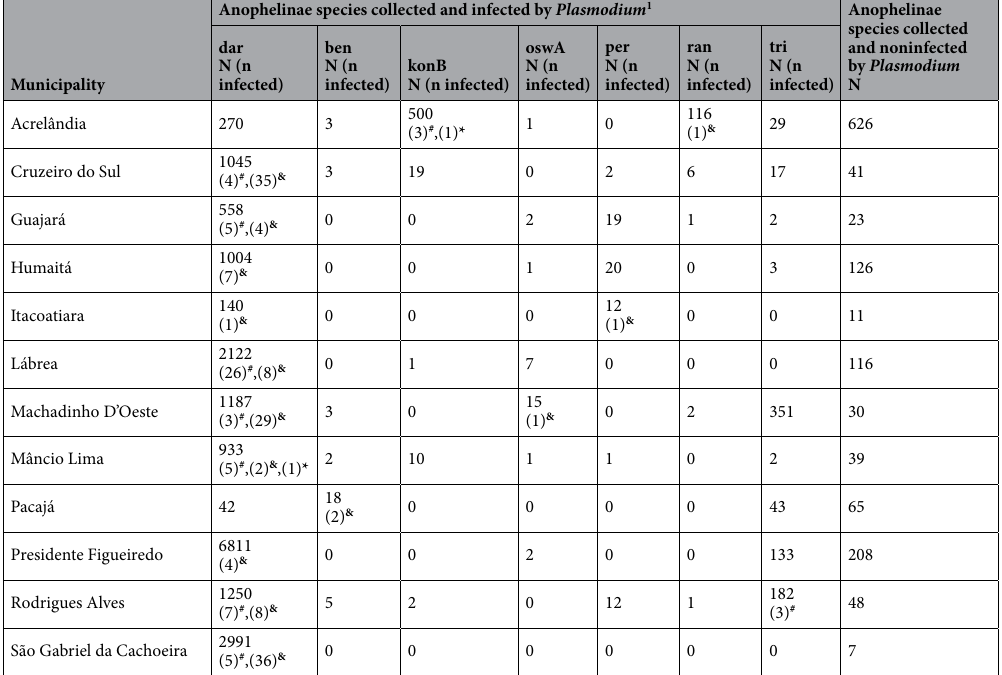
Table 1. Numbers of collected specimens tested for the presence of Plasmodium according to anopheline species, infection status, and municipality of origin. 1 dar, Ny . darlingi ; ben, Ny . benarrochi s.l.; konB, Ny . konderi B; oswA, Ny . oswaldoi A; per, An . peryassui ; ran, Ny . rangeli ; tri, Ny . triannulatus. 2 Ny . albitarsis , Ny . arthuri , Ny . braziliensis , An . costai , Ny . deaneorum , Ny . dunhami , An . forattinii , Ny . goeldii , Ny . marajoara , An . mattogrossensis , An . minor , An . fluminensis , An . malefactor , An . punctimacula , Ke . neivai , St . nimbus , Ny . nuneztovari , Ny . oryzalimnetes , An . shannoni , St . thomasi , Chagasia fajardi , and other unidentified anopheline species 14 . # Plasmodium falciparum . & Plasmodium vivax . * Mixed infection ( Plasmodium vivax and Plasmodium falciparum